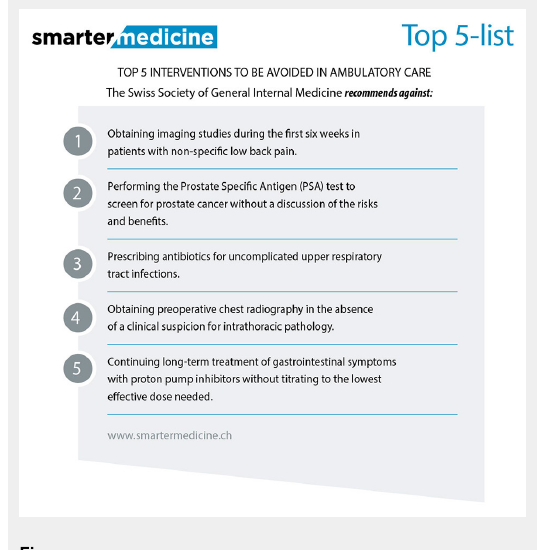
Figure Top five list of the Swiss Society of General Internal Medicine. May